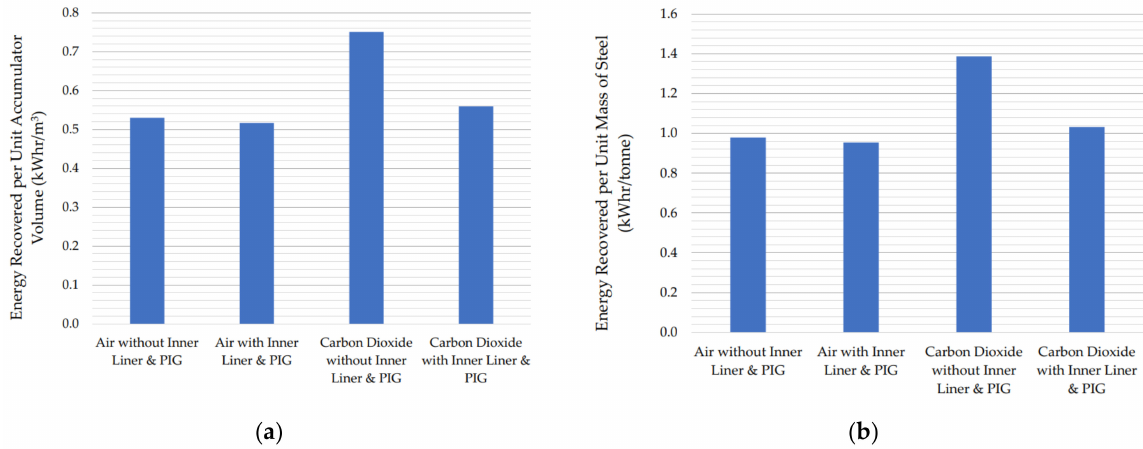
Figure 10. ( a ) Energy recovered per unit accumulator volume (kWhr/m 3 ) and ( b ) energy recovered per unit mass of steel (kWhr/kg) for the systems with/without inner liner and pipeline inspection gauge, having air and CO 2 as the compressible gas while the system operates at 250 kW for both charging/discharging stages and 4 h for both hold